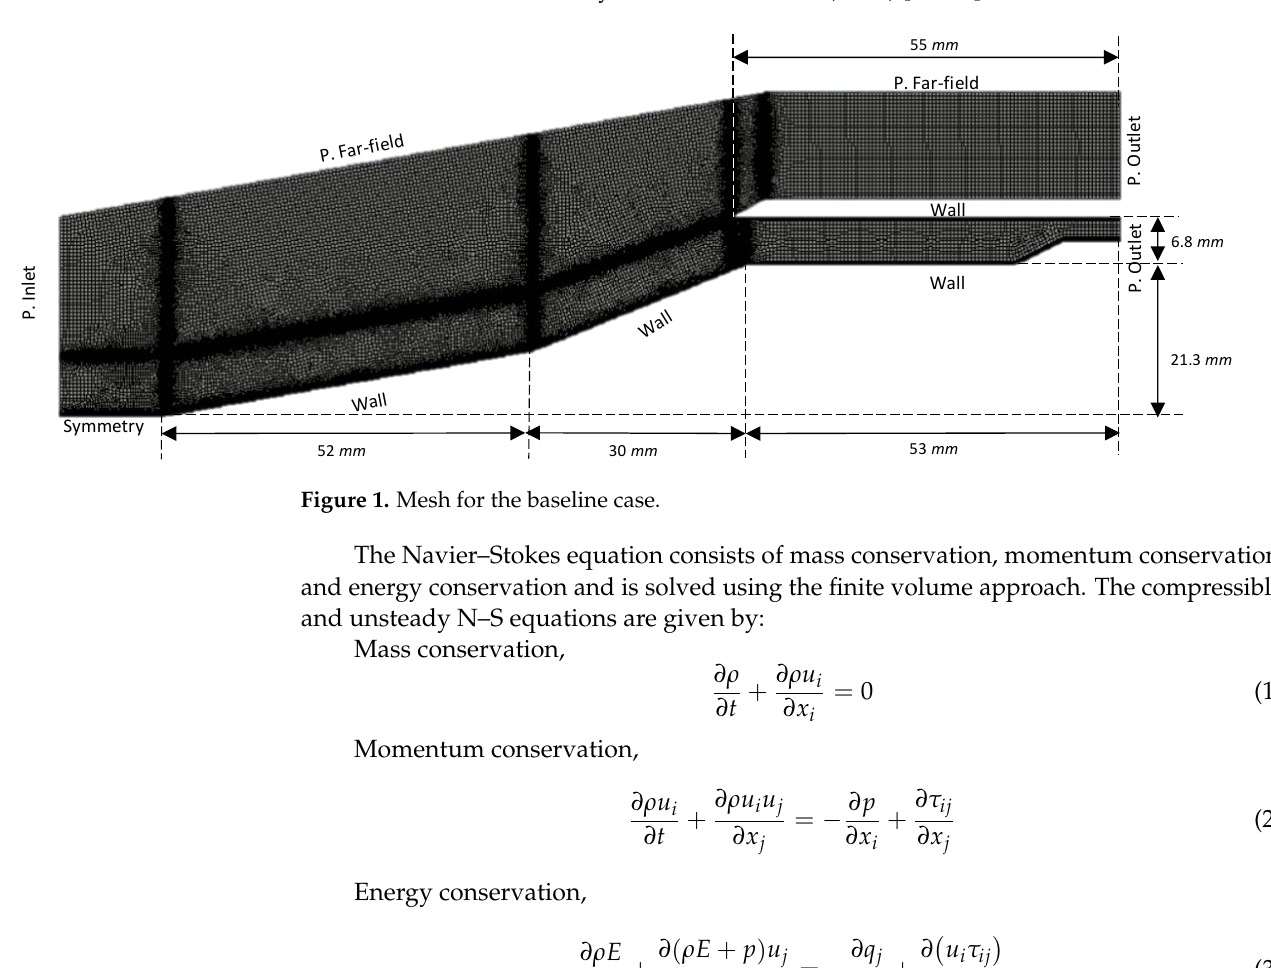
Figure 1 indicates the two-dimensional numerical domain used in the present study. The inlet w as set as a pressure inlet and the outlet as a pressure outlet.